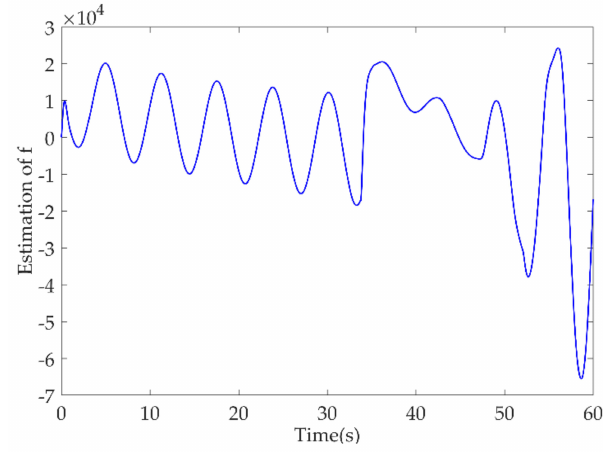
Figure 13. RBFNN estimation for f .